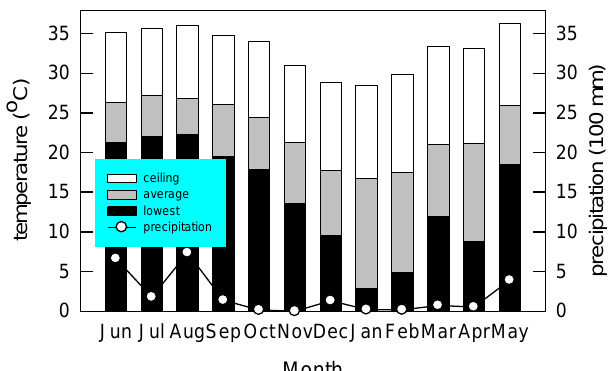
Figure 1. Monthly air temperatures (bar) and precipitation (circle) during the study period from June 2019 to May 2020 at the lower-elevation mountain area of central Taiwan (120 ◦ 46 (cid:48) 22 (cid:48)(cid:48) E, 23 ◦ 52 (cid:48) 19 (cid:48)(cid:48) N). The experiment consisted of two agricultural management systems (NT and SC) over four seasons (spring, summer, fall, and winter) with each cover crop treatment having four replications. Cover crops on the citrus field orchards were Paspalum conjugatum Berg., Cynodondactylon (L.) Pers., Wedelia chinensis Merr., and Oxalis corniculata L. NT orchards were mown with a flail mower in the first week of each season, with residues being left on the soil surface as a nutrient supply. During field management, organic cultivation methods were performed and no chemical fertilizers or herbicides were used in this experiment. In addition, no severe pests or diseases were encountered during these field experiments. Average citrus yield was about 18,000 kg ha − 1 in 2019. A completely randomized design employing the two tillage methods and four seasonal treatments was used, and there were five replicates per treatment. For each treatment, five intact, fully expanded mature leaves and leaf samples were randomly sampled from each robust and healthy plant at the end of each